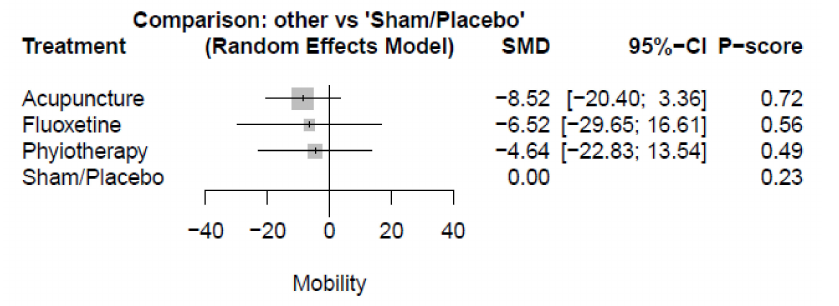
Figure 6. Plot of stiffness; SMD: standardized mean difference, CI: confidence